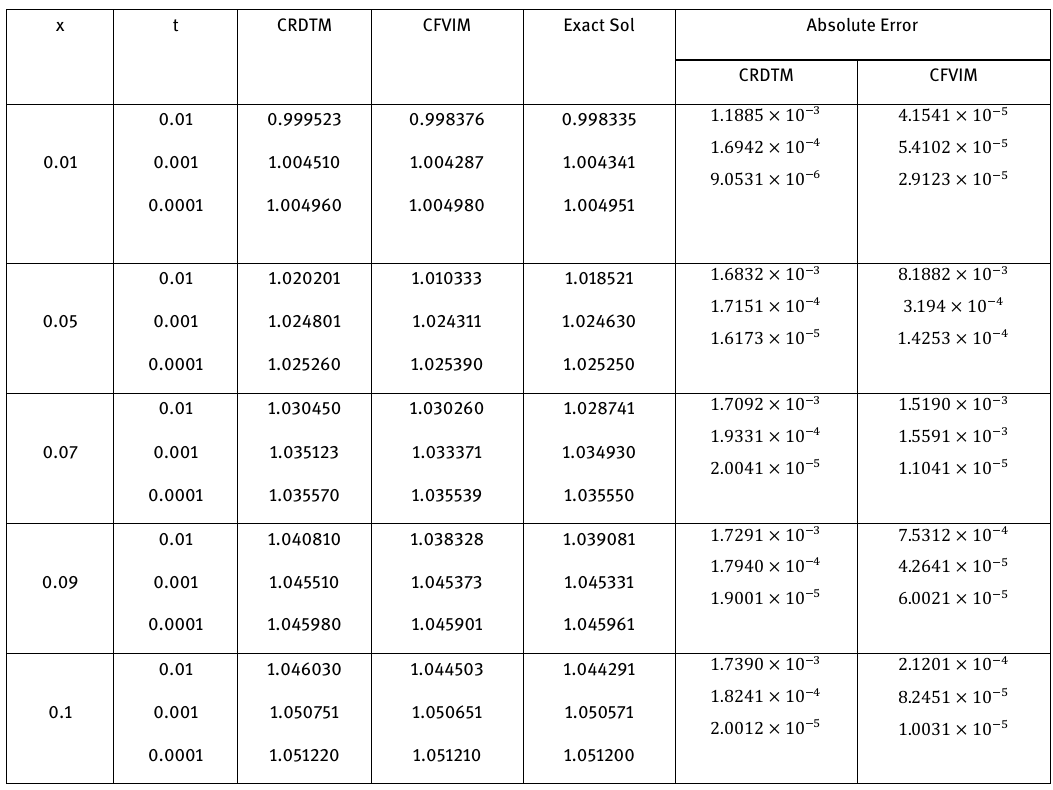
Table 3: Numerical analysis of solution Eq. (50), (55) and exact solution (56) for example 3 at α =1 x t CRDTM CFVIM